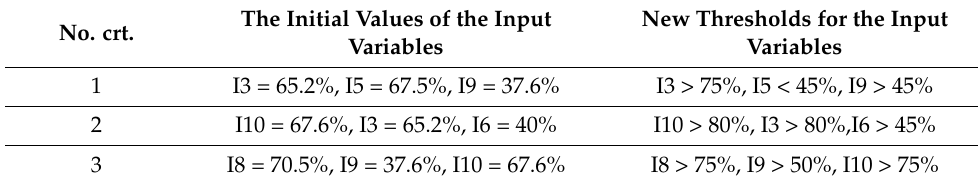
Table 6. Scenarios drawn up in order to raise the share of teleworkers in Romania. The Initial Values of the No. crt.